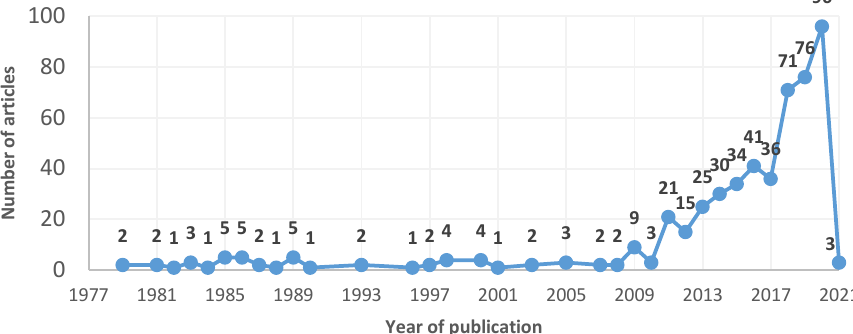
Figure 3. Yearly trend in the number of papers published on the retrofitting of residential buildings.